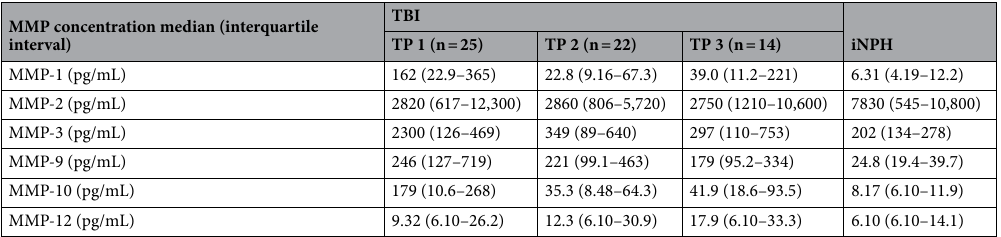
Table 3. CSF MMP concentrations between TBI (three time points) and iNPH groups. iNPH idiopathic normal pressure hydrocephalus, MMP matrix metalloproteinase, TP time point, TBI traumatic brain